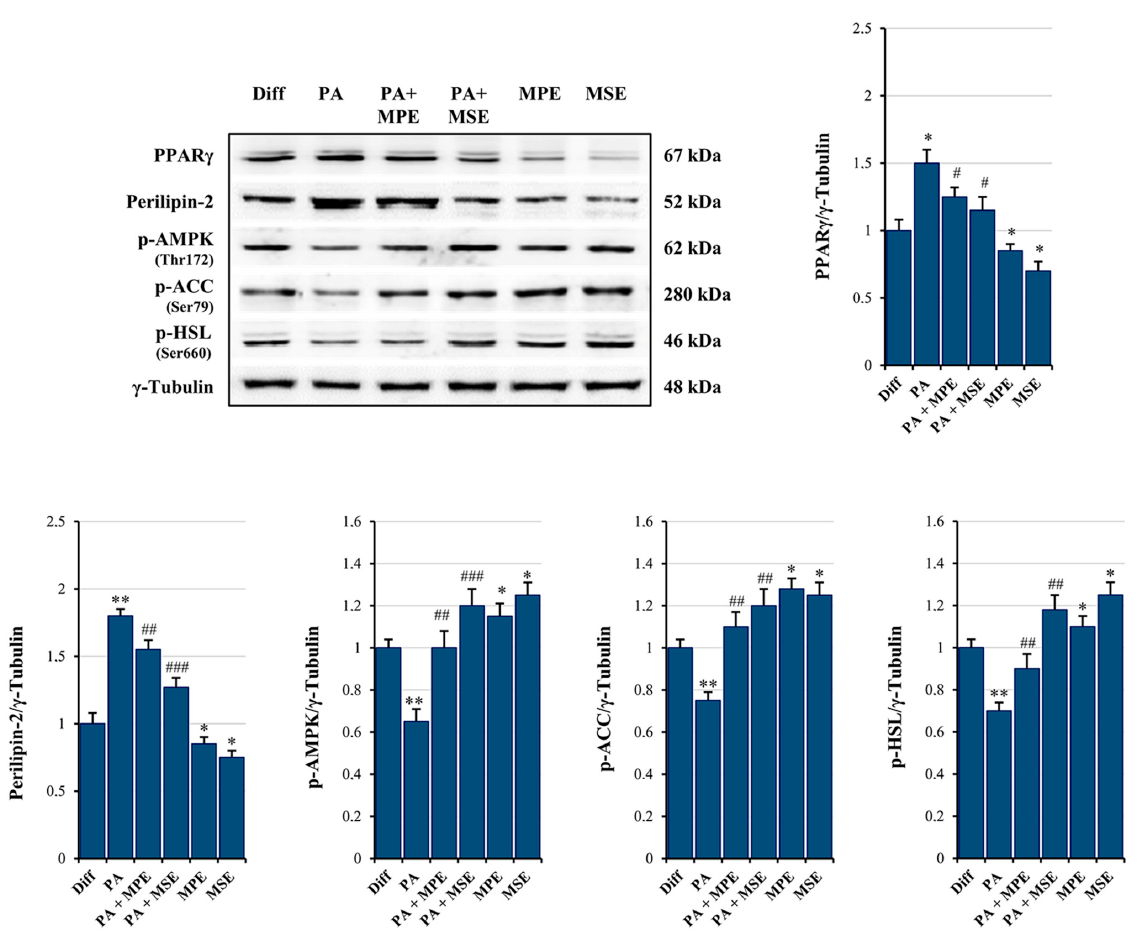
Figure 4. MPE and MSE reduce lipid accumulation, preventing lipogenesis and promoting lipolysis. Differentiated 3T3-L1 adipocytes were treated with 500 µ M PA for 48 h in the presence or absence of 100 µ g/mL MPE or MSE, as reported in Section 4. Then, cell lysates were analyzed by Western blotting using specific primary antibodies directed against PPAR γ , Perilipin-2, phosphorylated AMPK (p-AMPK), phosphorylated ACC (p-ACC) and phosphorylated HSL (p-HSL). Equal amounts of proteins were loaded in each lane (30 µ g) as normalized by γ -Tubulin detection. The bar graphs represent the means of three independent experiments ± SD. The statistical differences between groups were evaluated using a one-way ANOVA test. * p < 0.05, ** p < 0.01 were significant with respect to differentiated 3T3-L1 adipocytes. # p < 0.05, ## p < 0.01, ### p < 0.001 were significant with respect to PA-treated differentiated 3T3-L1